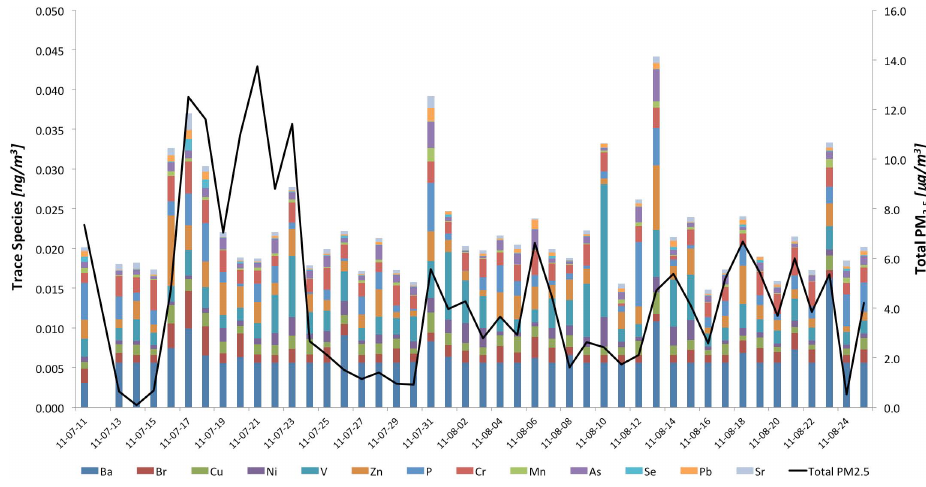
Fig. 7. Time series of total PM 2 . 5 mass and trace species